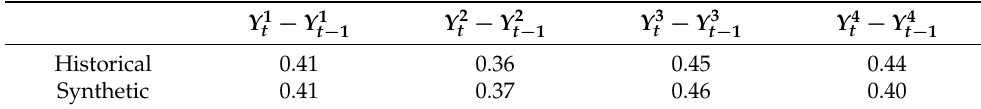
Table 6. Comparison of historical and simulated rank auto-correlations.